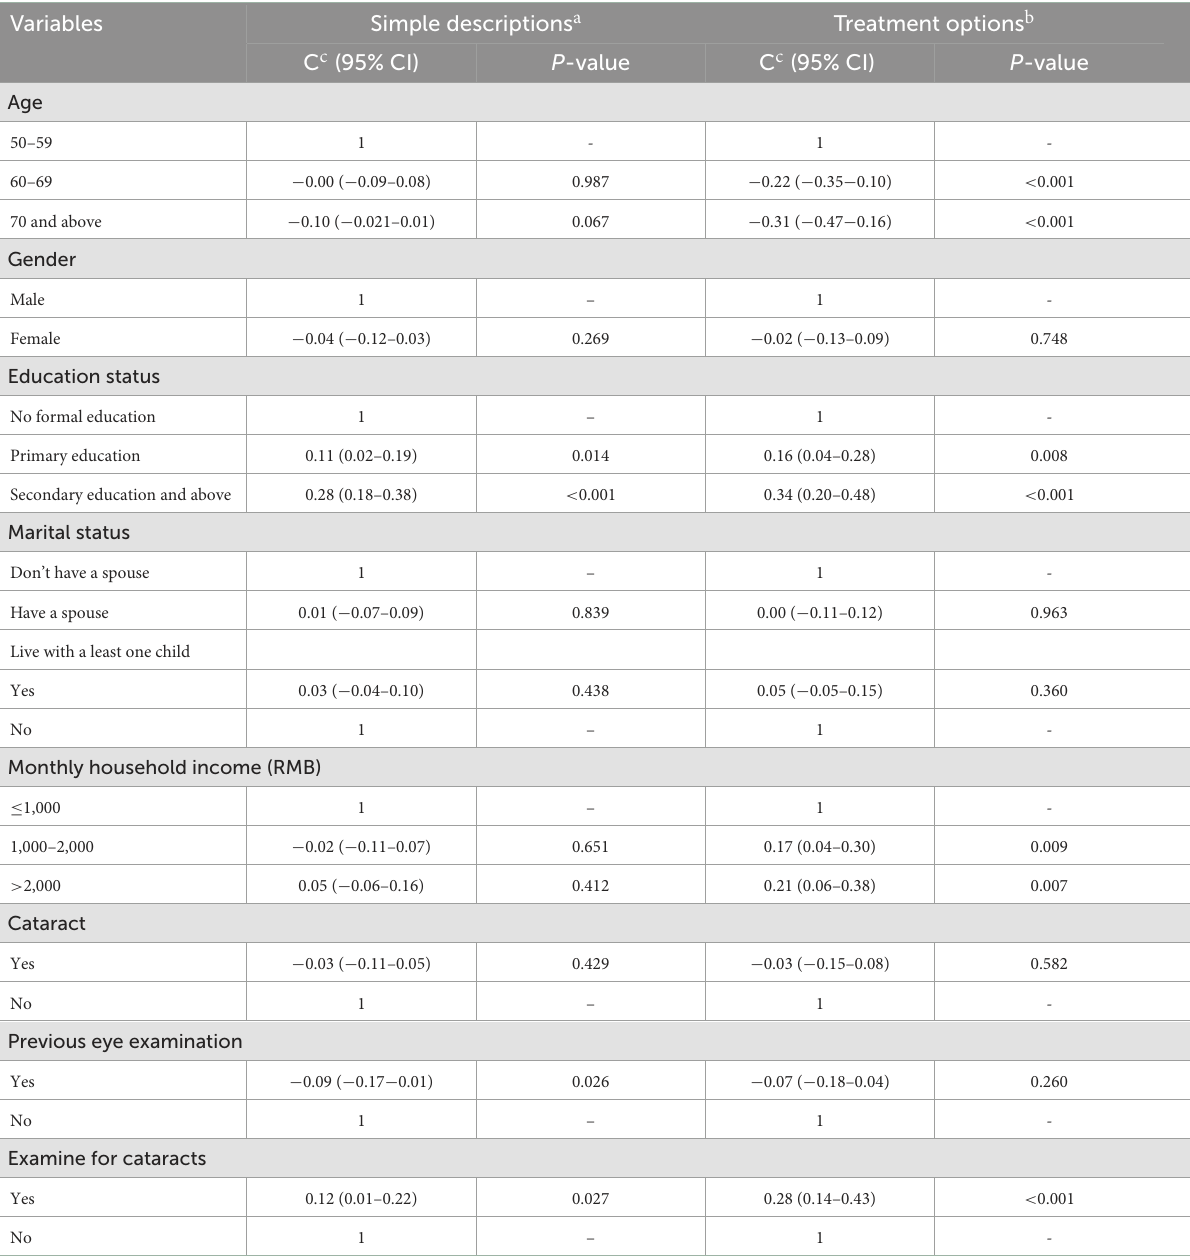
TABLE 4 Factors associated with simple descriptions, treatment options for cataracts of adults aged 50 and above in rural western China 2021.